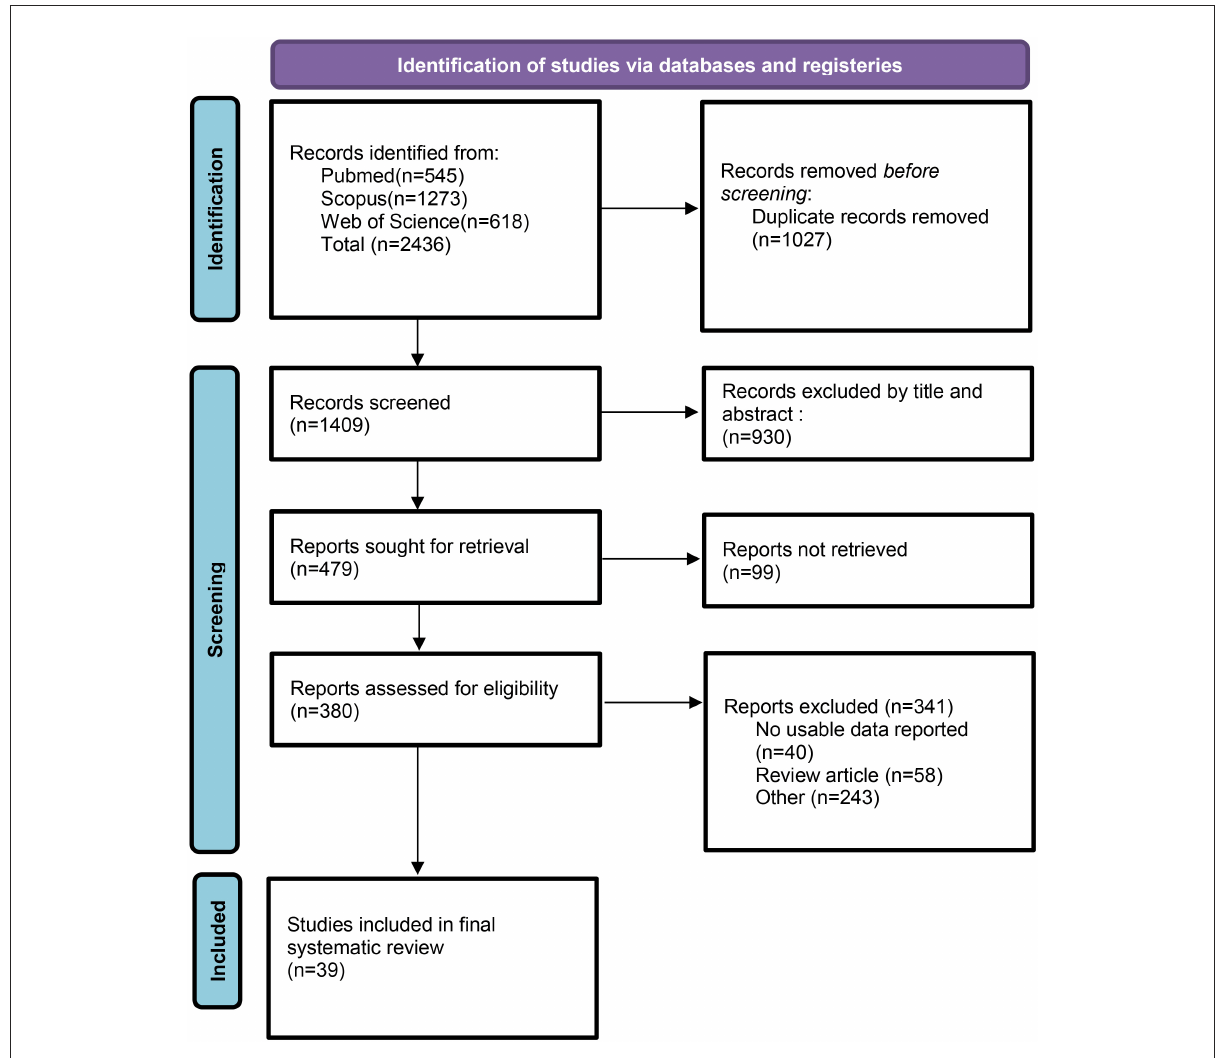
FIGURE1 Flow chart for study identification and selection. Based on PRISMA